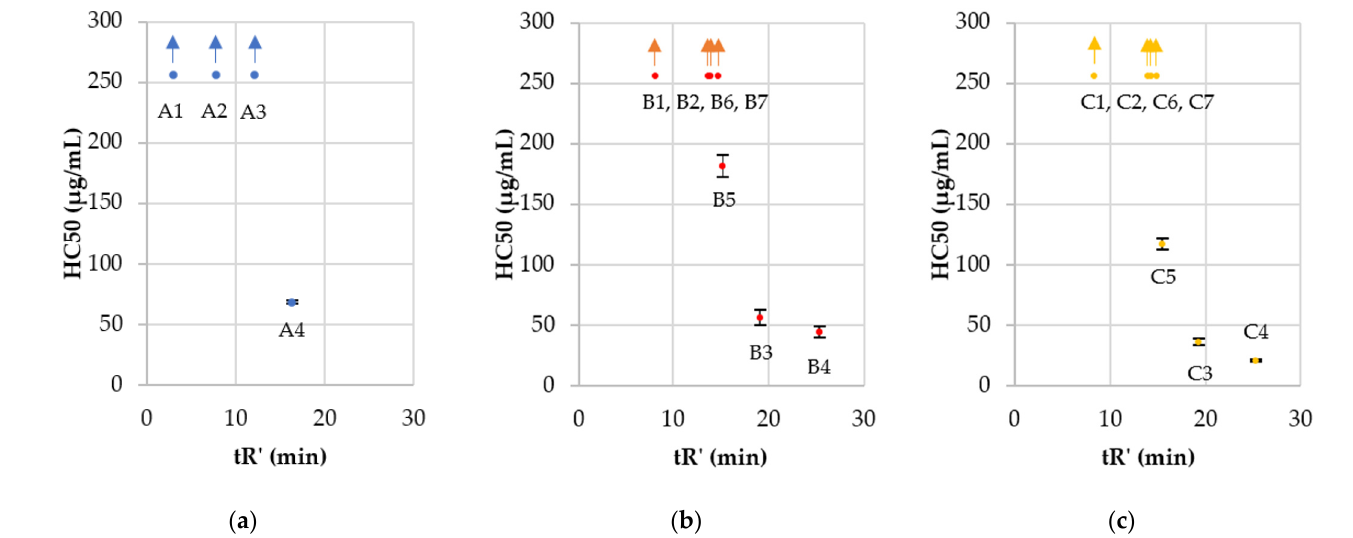
Figure 6. Hemolysis (HC 50 ) vs. adjusted retention time (tR’): ( a ) USCL—parent molecules (series A ); ( b ) gemini lipopeptides with L-lysine amide spacer (series B ); ( c ) gemini lipopeptides with L-cystine diamide spacer (series C ). Arrows indicate that HC 50 was above the applied concentration range.